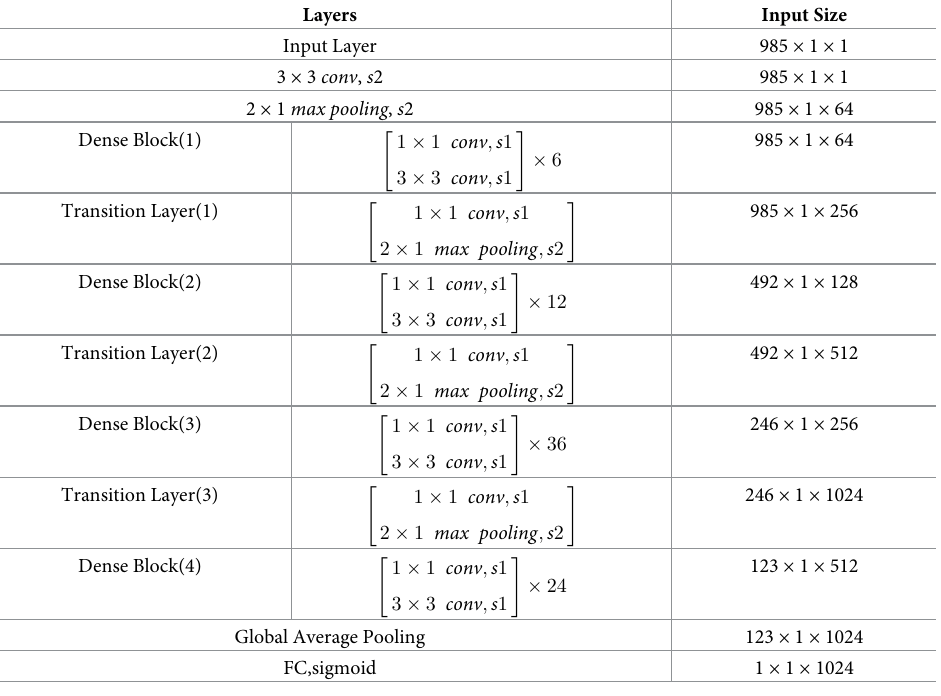
Table 1. The parameters of the constructed model based on